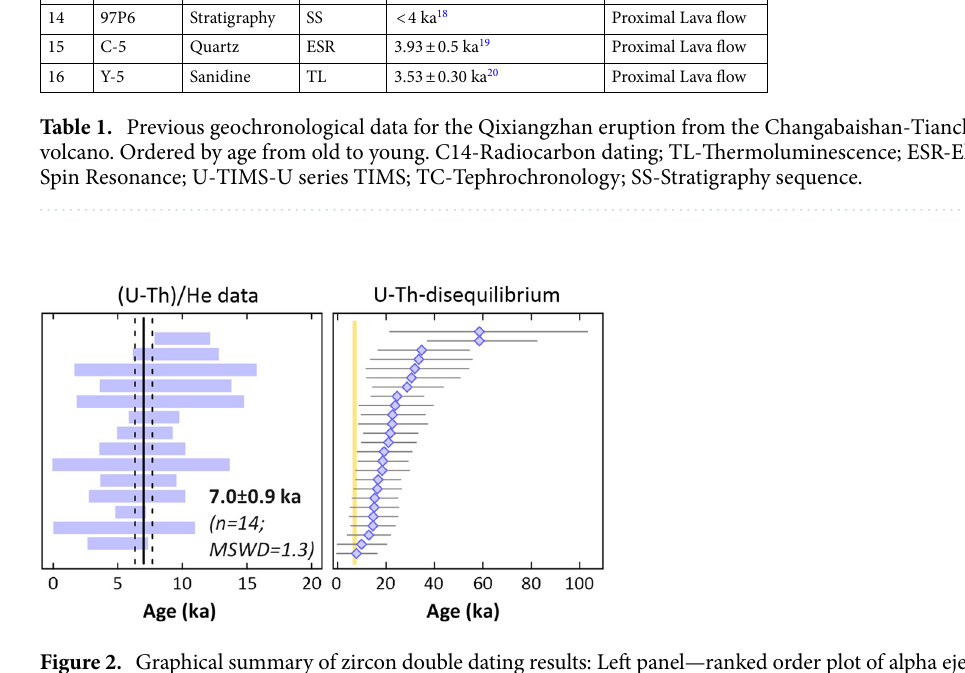
Figure 2. Graphical summary of zircon double dating results: Left panel—ranked order plot of alpha ejection and disequilibrium corrected zircon (U–Th)/He dates displayed as 2σ error bars. Weighted mean (solid black line) and 95% confidence interval (dashed black lines) represent our best ZDD estimate for the time of eruption and its uncertainty (or ZDD eruption age). Right panel—ranked order plot of zircon U–Th ages with 1σ analytical uncertainties. Deep yellow bar indicates the 95% confidence interval of the ZDD eruption age. Note that U–Th ages provide maximum eruption age and the youngest U–Th ages overlap within uncertainty with the ZDD eruption age, providing additional confidence in the